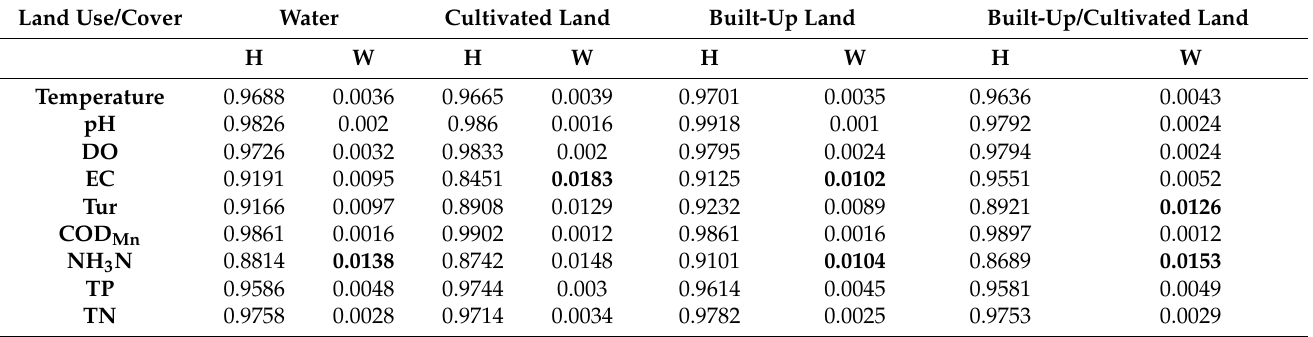
Table 3. Entropy weights of water quality parameters for different LULC patterns in